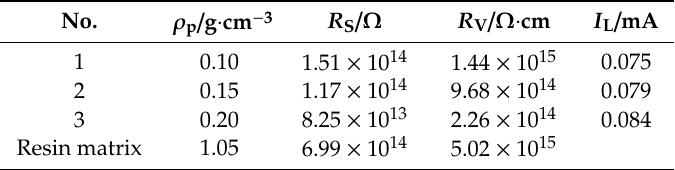
Table 2. Insulation characteristics of the polyurethane